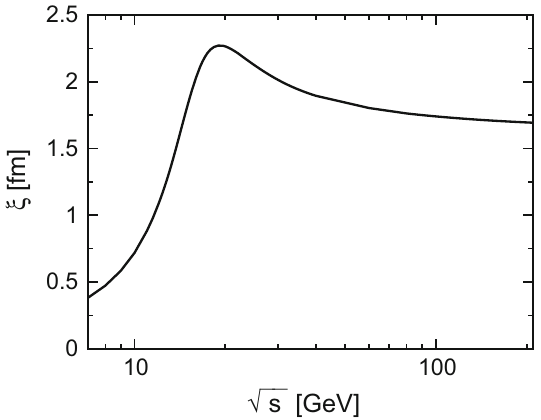
Fig. 5 Beam energy dependence of ξ along the considered chemical freeze-out curve (see Fig. 1). The correlation length falls off slower in √ s , as is expected from the underly- the crossover regime, i.e. at larger inguniversalityclass.Thedepictedresultwillbedescribedqualitatively with the phenomenological ansatz for ξ introduced in [12], if a compa- rable size of the critical region is